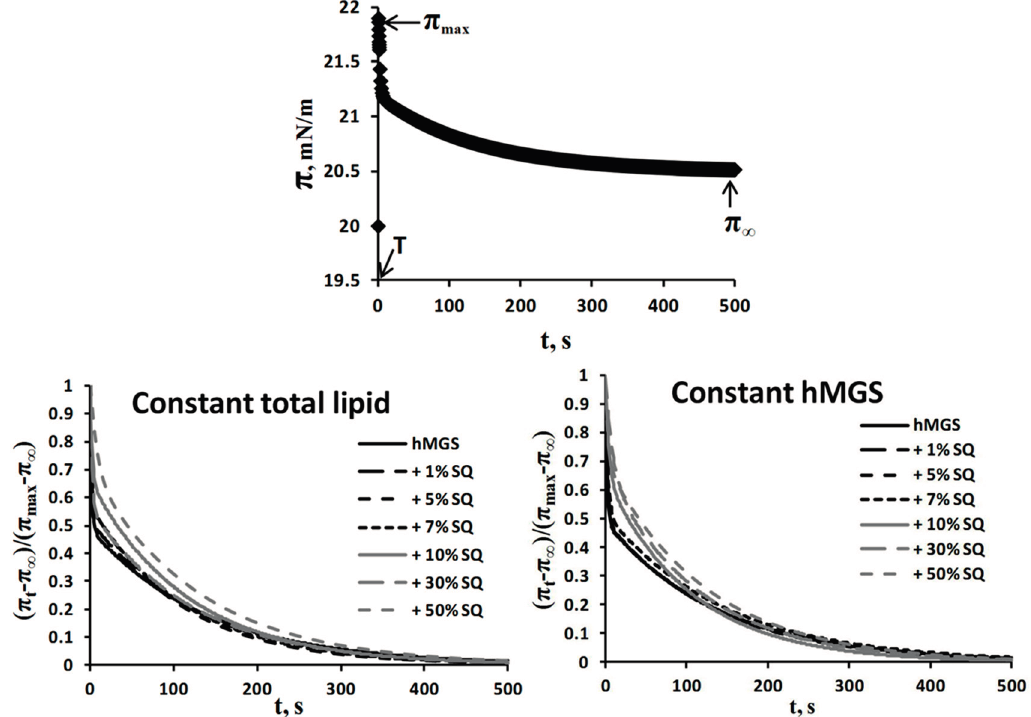
Figure 8. Upper panel: Typical stress-relaxation curve for film by equiweight meibum mixture (the subphase in the example is pure saline solution). The small compression deformation is completed in moment T and from this moment on the surface pressure starts to relax from a maximum value π max to a new equilibrium value π ∞ . The surface pressure relaxation transient is analyzed by fitting with the equation of double exponential decay shown to chart (see Equation (1)); and Bottom panels : Surface pressure relaxation transients of hMGS/SQ films. The data are presented in the format required for further fitting by double exponential decay Equation (1) as dependence of ( π t − π ∞ )/( π max − π ∞ ) on t . The time axis is normalized to begin from the start of the relaxation (the moment T). Data from stress-relaxation experiments with all hMGS/SQ films are summarized in Table